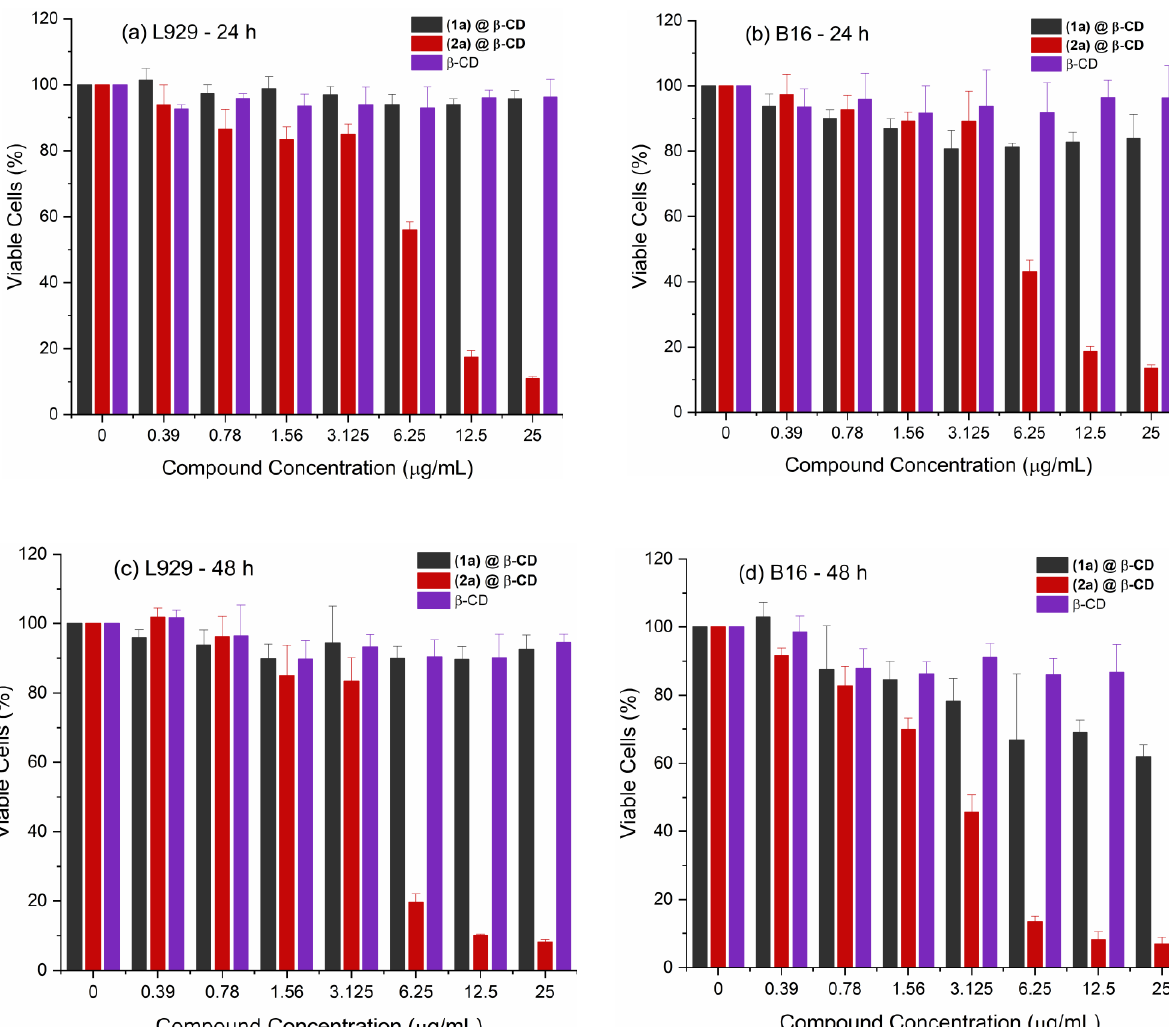
Table 2. IC 50 values and calculated TI for the compounds tested.